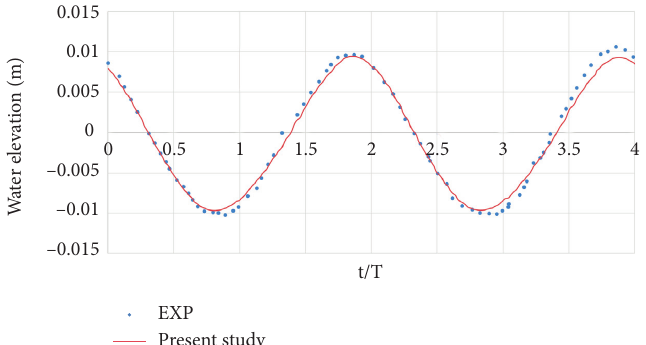
Figure 5: Water surface elevation at x � 5 . 2.